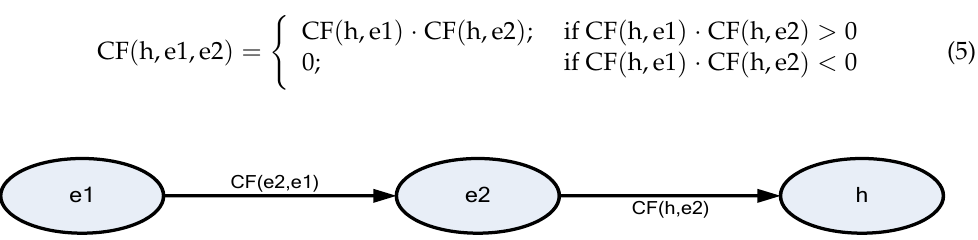
Figure 4. Serial transitions between two observations and the hypothesis (the authors’ own study based on [2]).